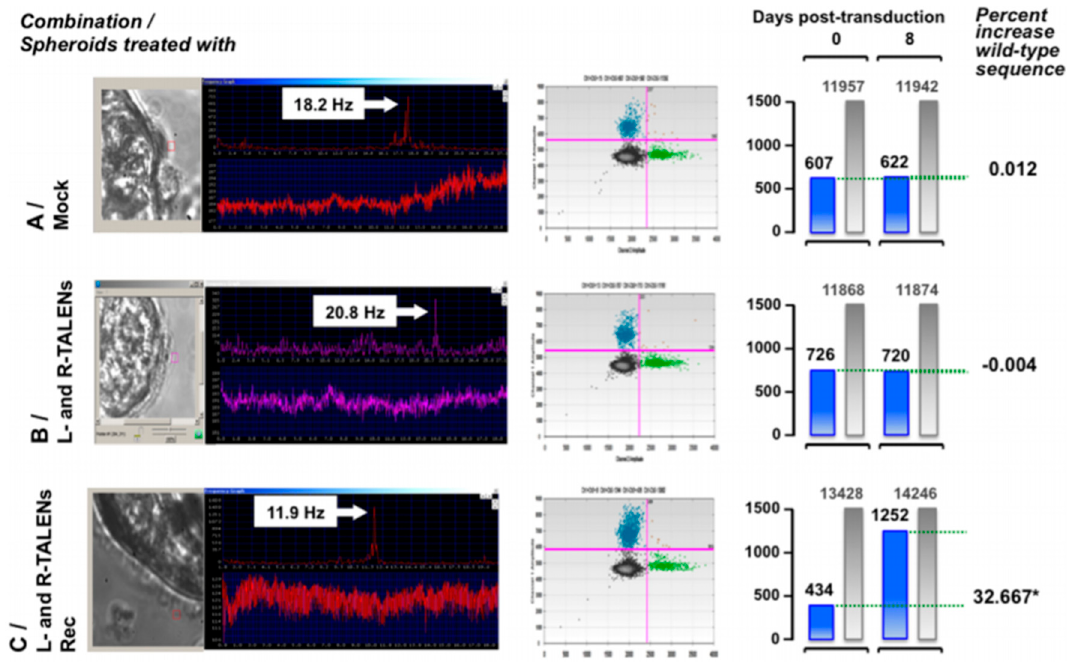
Figure 6. Analysis of ciliary motility and number of wild-type alleles at day 0 and 8 post-transduction. Spheroids from patient A were transduced with the vectors indicated on the left and monitored every 2 days for ciliary beating pattern and frequency. Panels show the ciliary beat frequency measured at day 5 post-transduction for untreated cells (upper panel), cells treated with L-and R-transcription activator-like effector nucleases (TALENs) (middle panel), and L-and R-TALENs and Rec (lower panel). The latter treatment reduced beating frequency to normal levels (12–14 Hz). Normalization lasted throughout the observation treatment. At day 0 and 8 post-treatment, spheroids were collected in part and processed to extract the genomic DNA. Extracted nucleic acids were analyzed by droplet digital PCR (ddPCR) to count the number of molecules containing the wild-type sequence at nucleotide position 172 381. The center gray panels show, spatially separated, the wild-type sequence molecules in the top left quadrant (blue dots), mutated sequence molecules in the lower right quadrant (green dots), and irrelevant molecules in the lower left quadrant (gray dots) counted by ddPCR. The histograms on the right show the number of wild-type sequence molecules counted in spheroids at day 0 and 8 post-transduction and the percentage increment increase in wild-type molecules between the time points. Spheroids treated with L- and R-TALENs and Rec show > 30% increase in wild-type molecules. This increase reached statistical significance (*) as determined by the sequential probability ratio test ( α value 0.01). Reproduced with permission from